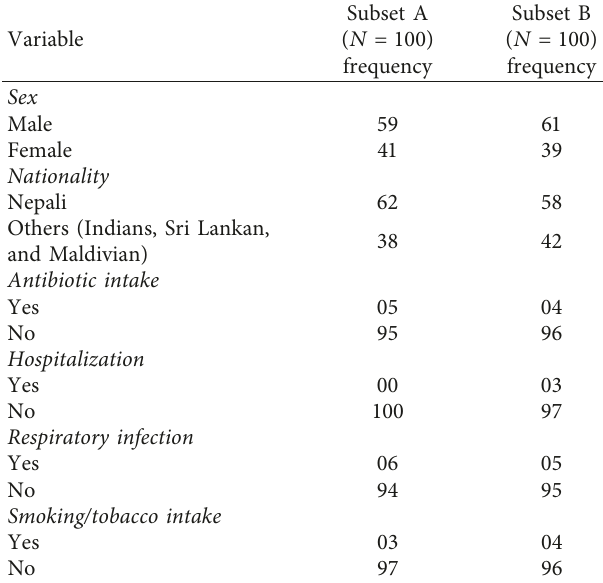
Table 1: Demographic and clinical details of the